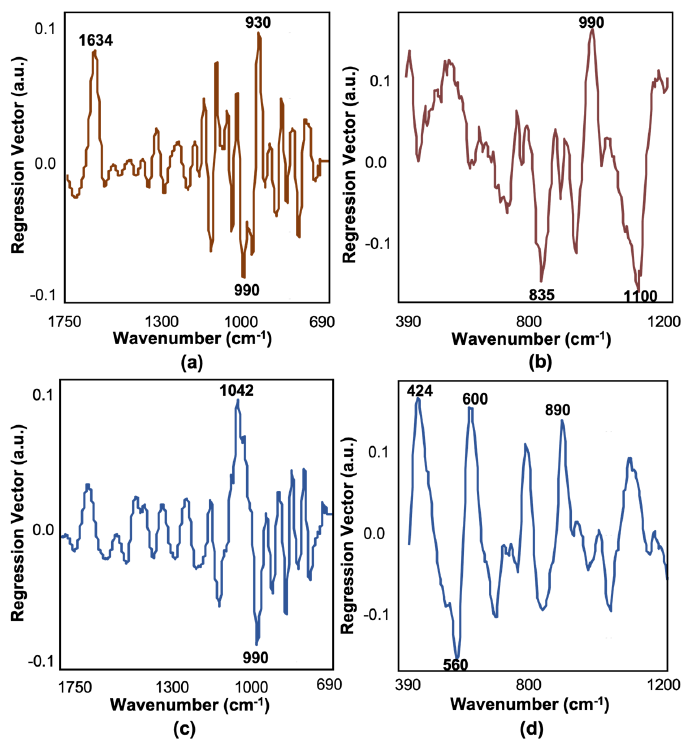
Figure A3. PLSR regression vectors for Brix ( a , b ) and sucrose ( c , d ), utilizing 4500 FT − IR and Raman data, respectively.